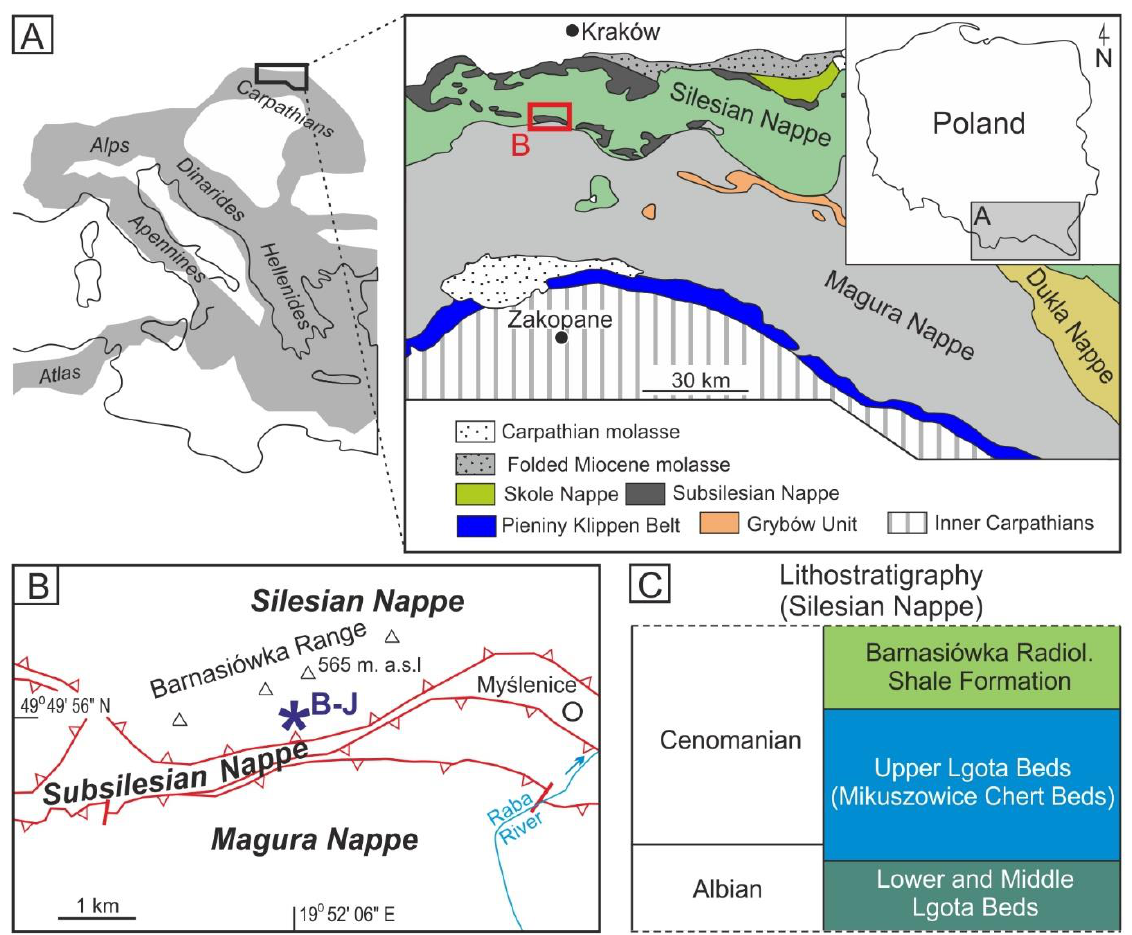
Figure 1. ( A ) A simplified geological map of the Alpine orogeny and its foreland, with marked area of the Western Central Carpathians [27] in its Polish part. ( B ) Detailed geological map of the studied area (a part of the Outer Carpathians after [28]) with location of the study area (Barnasiówka-Jasienica quarry; B – J). ( C ) Albian – Cenomanian lithostratigraphic scheme of the Silesian Nappe in the Outer Carpathians (after [29 – 32]).